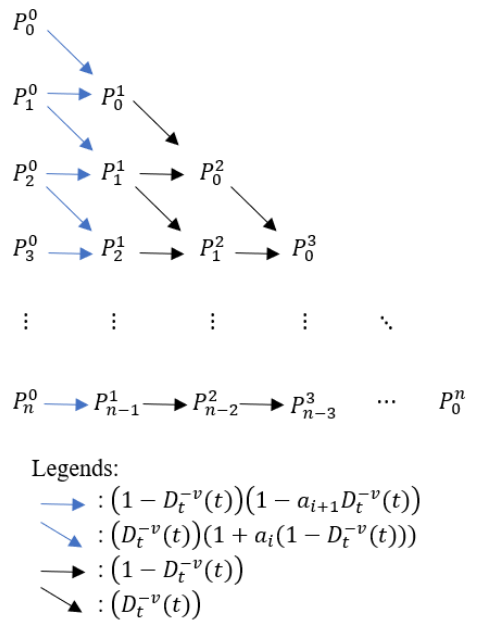
Figure 6. Fractional De Casteljau Algorithm Triangle